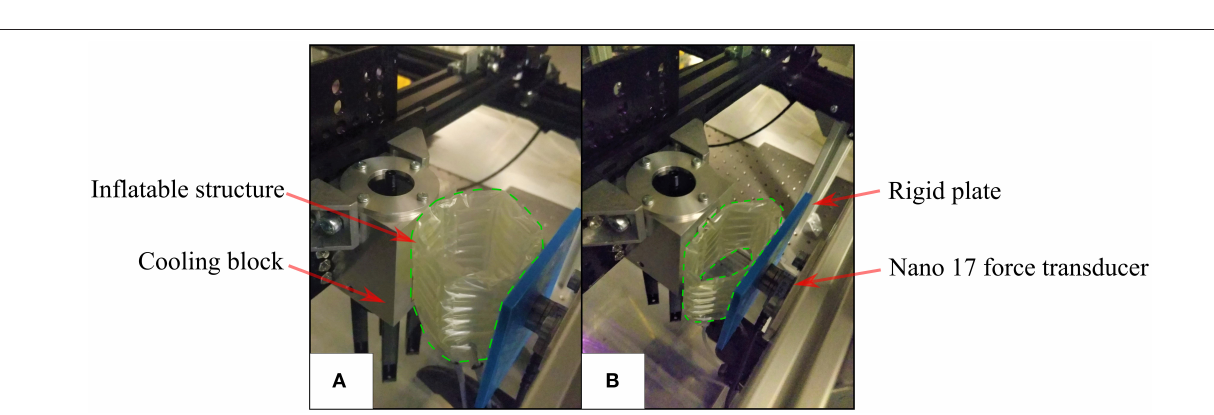
designs can be seen in Figure 8A . The values of radial stiffness when the circumferential beams were inflated to 1,500 mbar and the pressure in the stiffening chambers was varied can be seen in Figure 8B . As the pressure was increased, the structures were able to restore their original shape to a greater degree.